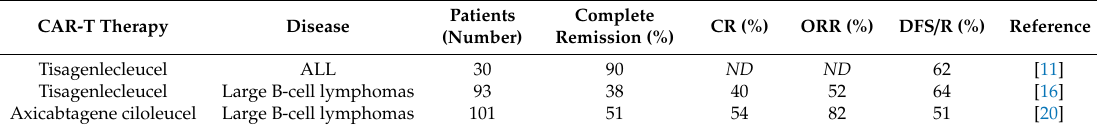
Table 4. Reported clinical e ffi cacies of CAR-T